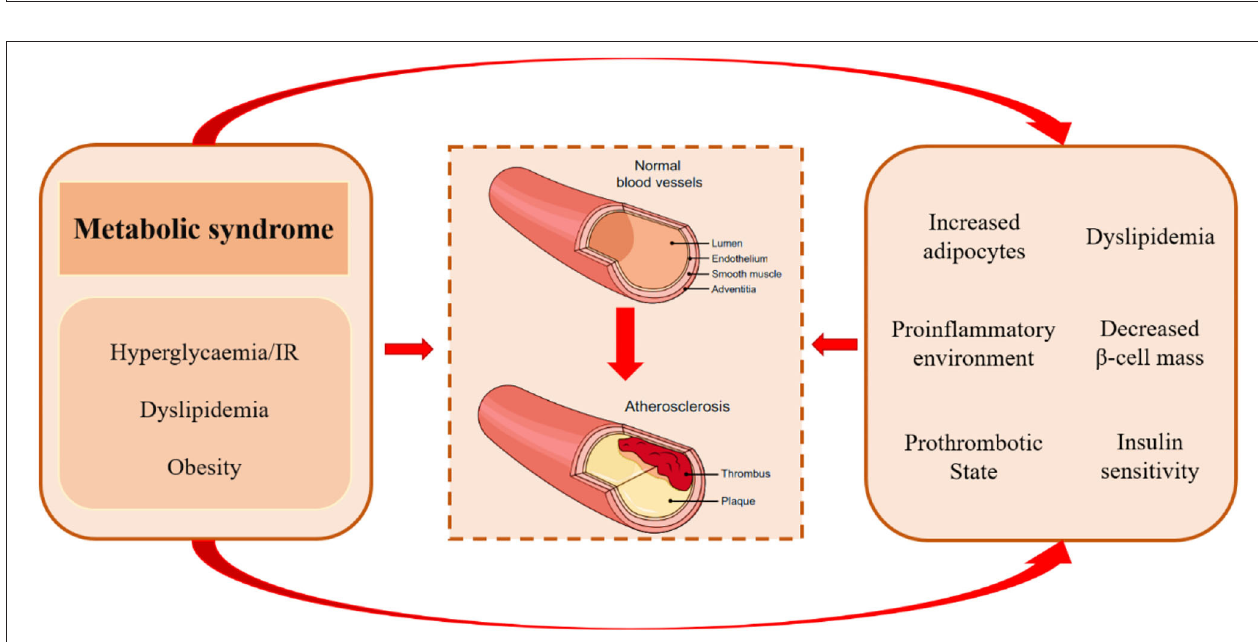
FIGURE 2 | Pathological mechanisms of atherosclerosis in metabolic syndrome. Metabolic syndrome comprises a complex group of metabolic disorders characterized by hyperglycemia/insulin resistance, dyslipidemia, and obesity. It may accelerate atherogenic progression via increased adipocytes, proinflammatory environment, prothrombotic state, excess concentration of free fatty acids, unfavorable lipidomics, and decreased insulin levels and insulin sensitivity.